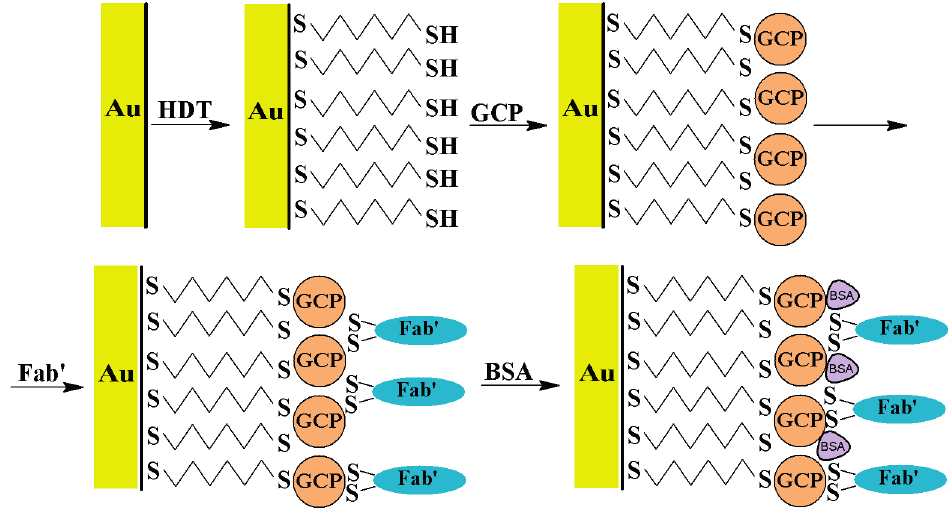
Figure 1. Schematic illustration of the process of immobilization of Fab’ fragments onto the gold electrode